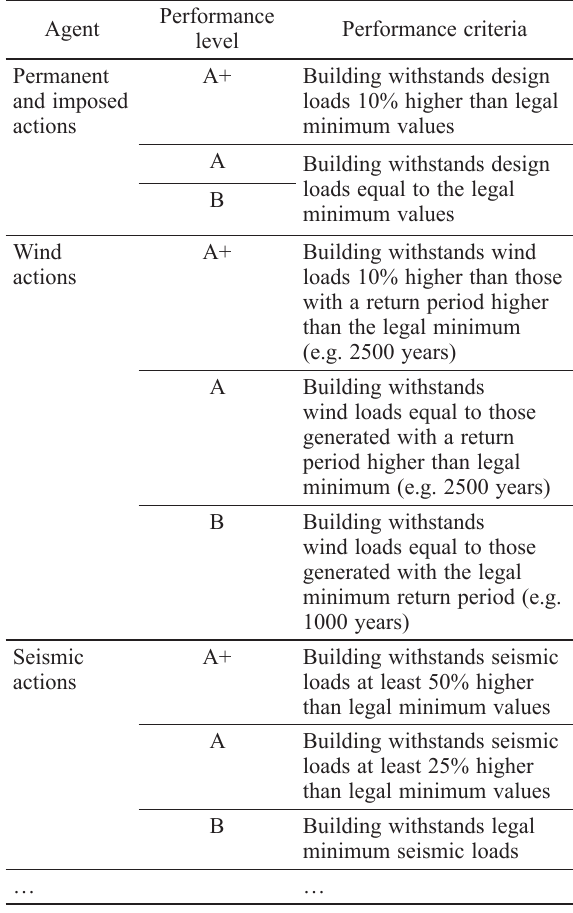
Table 4. Example of evaluation criteria for structural